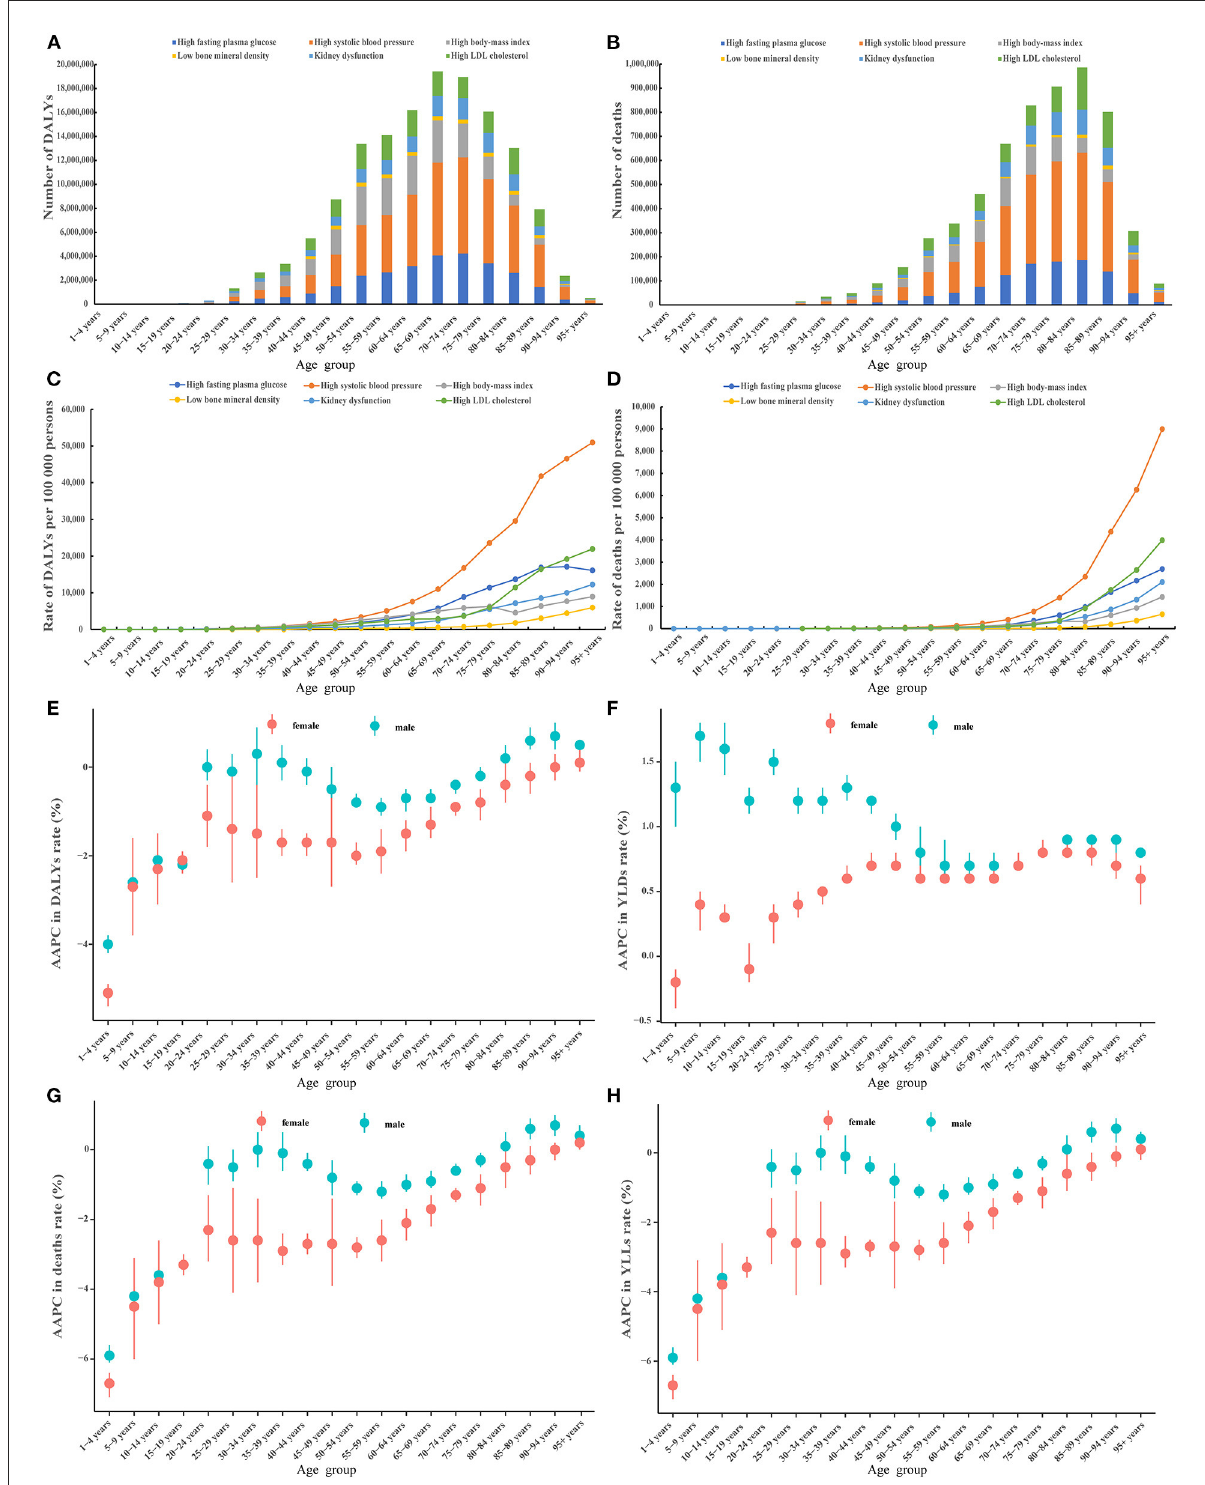
FIGURE1 Cross-sectional and longitudinal trend of the disease burden attributable to six metabolic risk factors throughout the human lifespan. Number of DALYs attributable to six metabolic risk factors across 20 age groups in 2019 (A) , number of deaths attributable to six metabolic risk factors across 20 age groups in 2019 (B) , rate of DALYs attributable to six metabolic risk factors across 20 age groups in 2019 (C) , rate of deaths attributable to six metabolic risk factors across 20 age groups in 2019 (D) , AAPC in the rate of DALYs attributable to metabolic risk factors